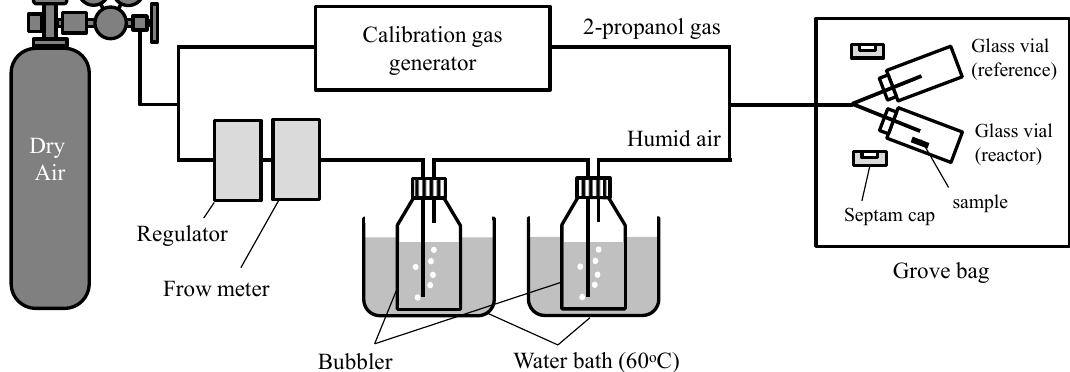
Figure 11. Apparatus settings for controlling the water content in gaseous 2-propanol.